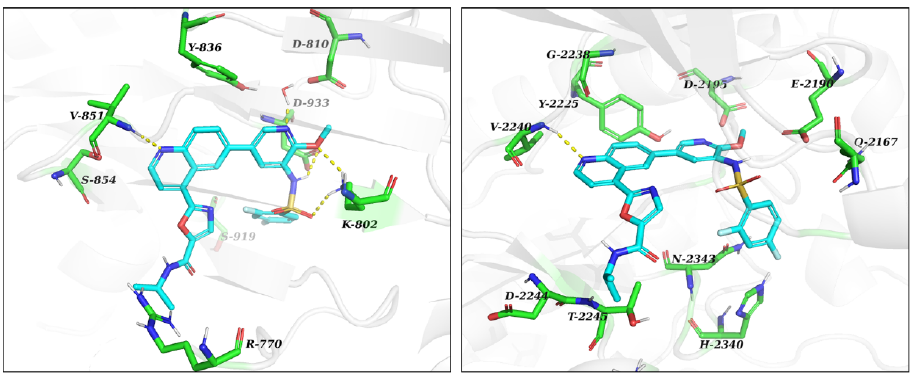
Figure 7. Predicted binding modes between 22c and the PI3K α ( left , PDB code for PI3K α is 4JPS), mTOR ( right , PDB code for mTOR is 4JT6). Hydrogen bonds are shown as yellow dashed lines. Images were generated with PyMOL.